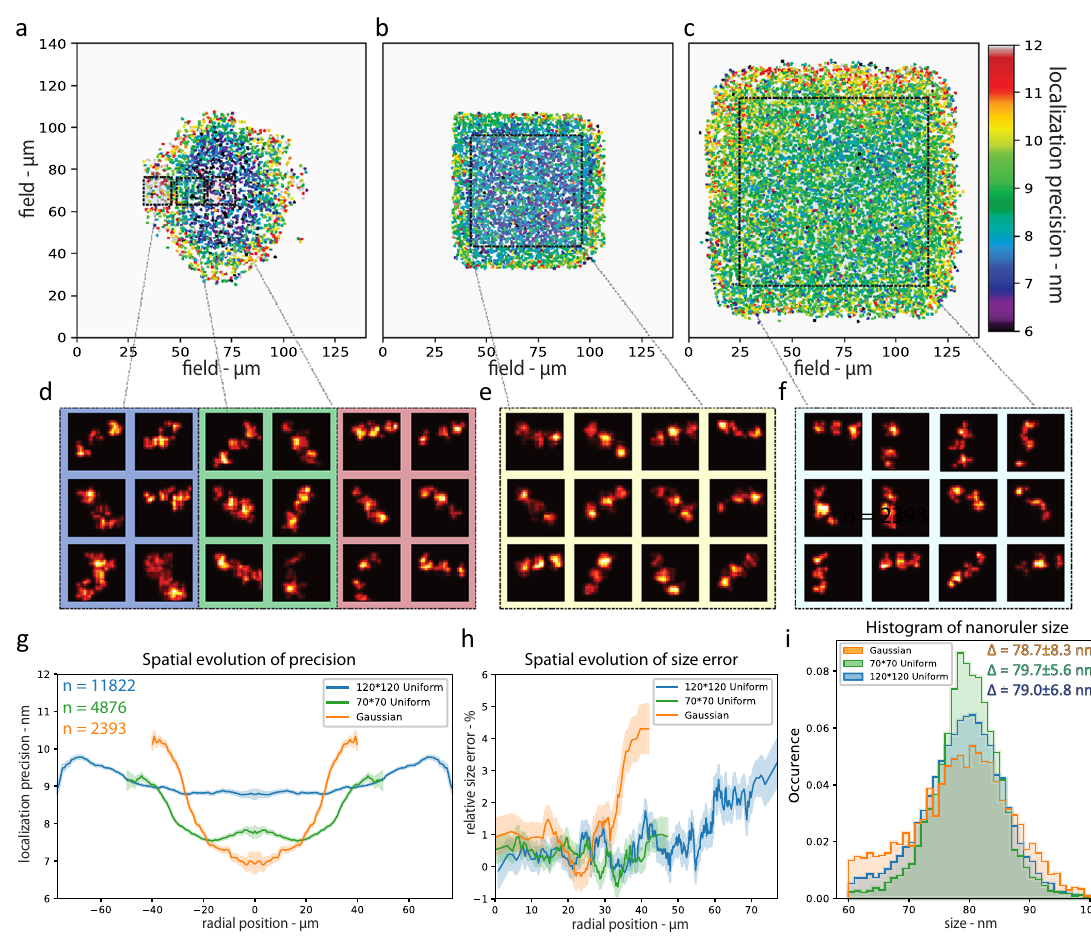
Fig. 3 Nanorulers imaging for localization precision estimation. DNA - PAINT imaging of 40 nm spaced 3 spots nanorulers, obtained with Gaussian ( a , d ), ASTER small fi eld of view (70 µ m × 70 µ m, b , e ), and ASTER large fi eld of view (120 µ m × 120 µ m, c , f ) illuminations. a – c are resulting localization precision maps where each point represents the average precision for one individual nanoruler (3 spots). d – f are nanoruler super-resolution images (150 nm × 150 nm), taken randomly from highlighted areas in a – c . g Mean localization precision along FOV radius for each excitation scheme (symmetrized). The number of nanoruler for each excitation scheme is indicated in a similar color. For each colored curve, the surrounding transparent curve indicates the standard deviation around the mean precision at a given radius. h Resulting size estimation error along FOV radius for each excitation scheme. A size error above 0 indicates that the nanoruler spots were measured <80 nm apart. Each colored curve is surrounded by a transparent curve that indicates the standard deviation around the mean size. i Resulting size measurement histogram for each excitation scheme. The mean and the standard deviation for the size (symbolized by Δ ) are indicated in the upper right